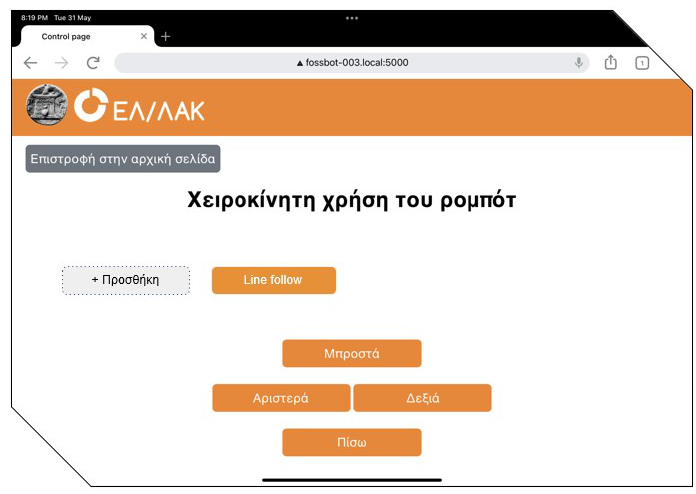
Figure 4. No-coding UI preview.